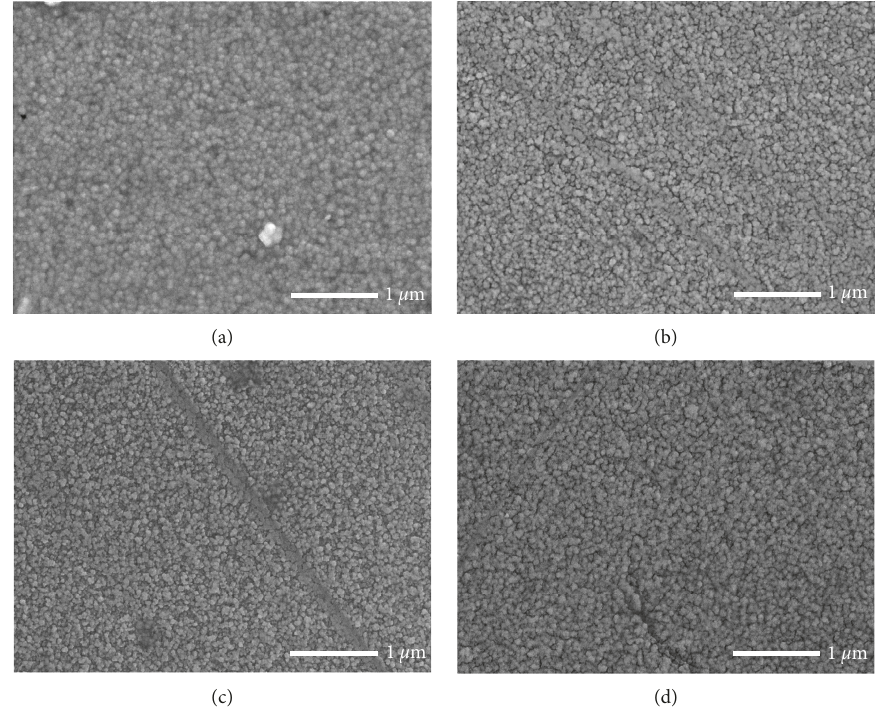
Figure 4: SEM images of CdS thin films placed into CuCl and (d)